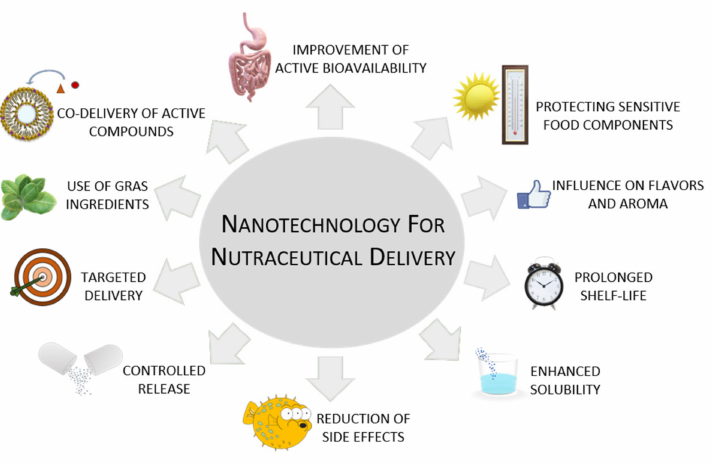
Figure 1. The main advantages of nanoencapsulation of nutraceuticals in the food field. “GRAS” is a Food and Drug Administration designation that means “Generally Recognized as